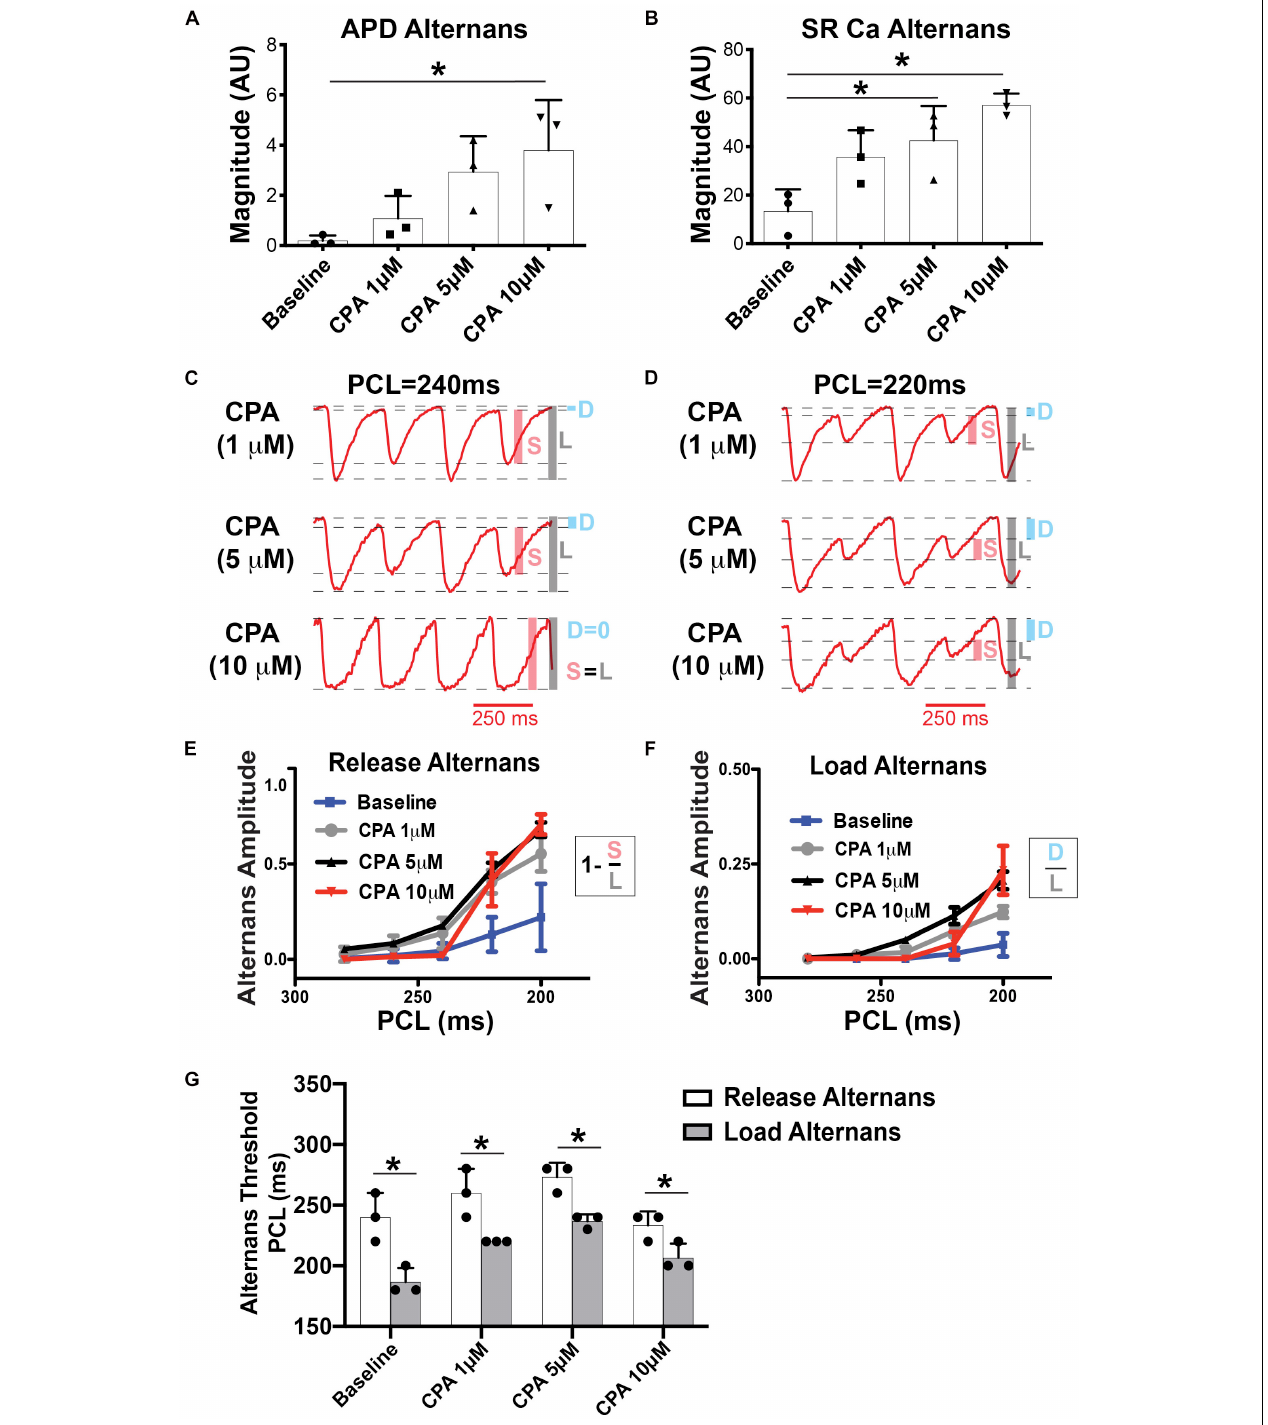
FIGURE 3 | At pacing cycle length (PCL) = 220 ms, cyclopiazonic acid (CPA) increased the magnitude of both action potential duration (APD) (A) and sarcoplasmic reticulum (SR) Ca 2 + (B) alternans. Mean ± SD. N = 3 (* p < 0.05 vs. Baseline). (C,D) Example SR Ca 2 + traces at a slower (C) and faster (D) PCL. High-dose CPA (10 µ M) tended to decrease alternans magnitude at slower rates, while increasing alternans magnitude at faster rates. (E,F) Quantification of release (E) and load (F) alternans according to the equations indicated. Shaded bars in (C,D) show approximate measurements for calculations in (E,F) . S, small; L, large; D, diastolic level. (G) Under all conditions, release alternans emerged at a longer PCL than load alternans. Mean ± SD. N = 3 (* p < 0.05 vs. corresponding threshold for release alternans).